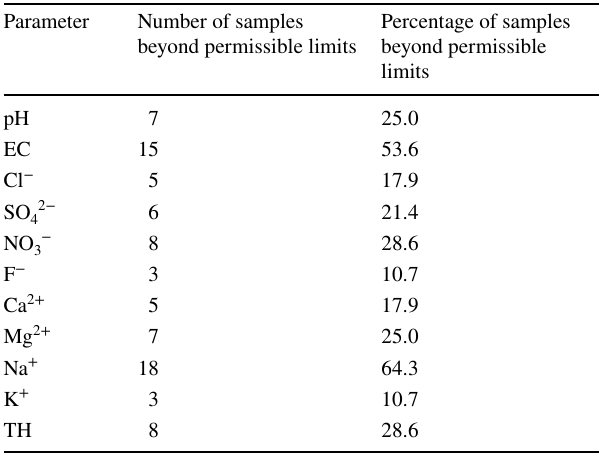
Table 5 Percentage of samples beyond the permissible limits for drinking water recommended by BIS (2012) Parameter Number of samples Percentage of samples beyond permissible limits beyond permissible